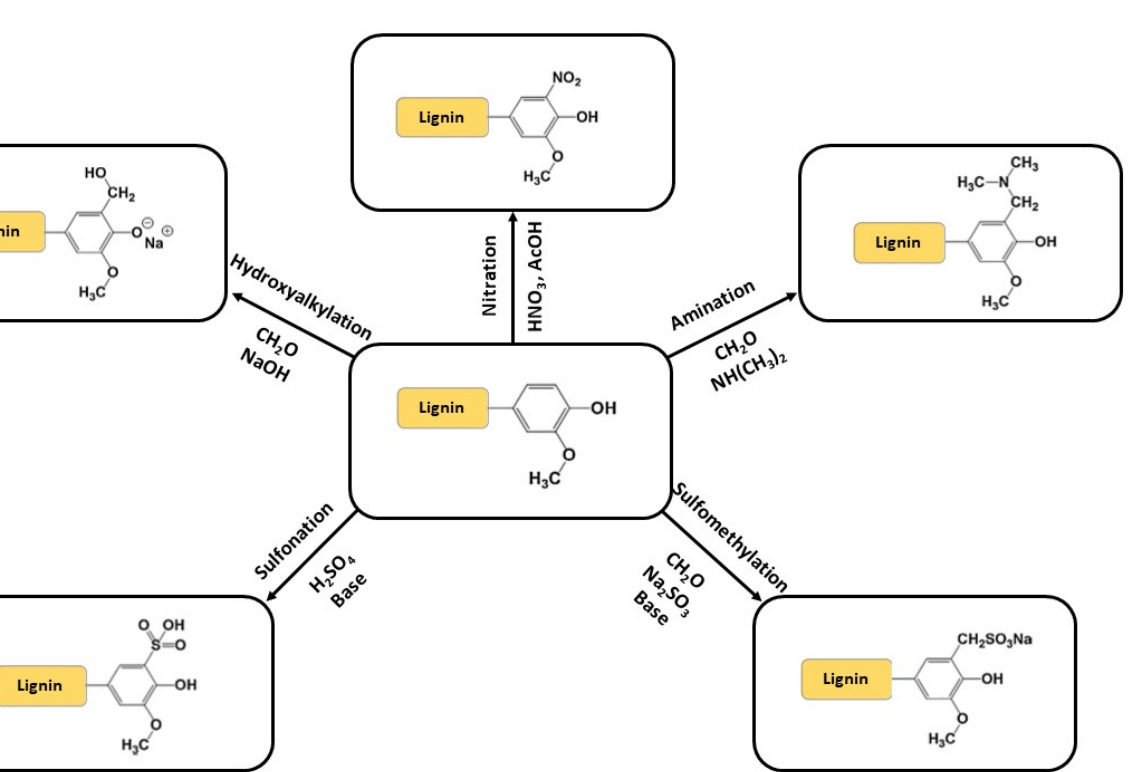
Figure 7. Synthesis of new chemically active sites by lignin chemical modification.